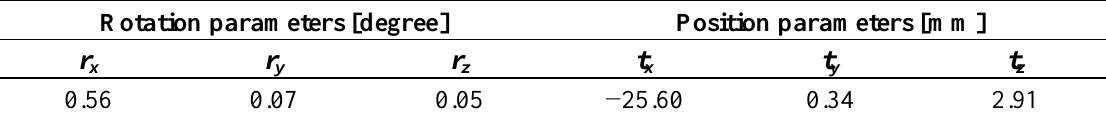
Table 2. Exterior orientation parameters of the RGB camera relative to the IR camera.